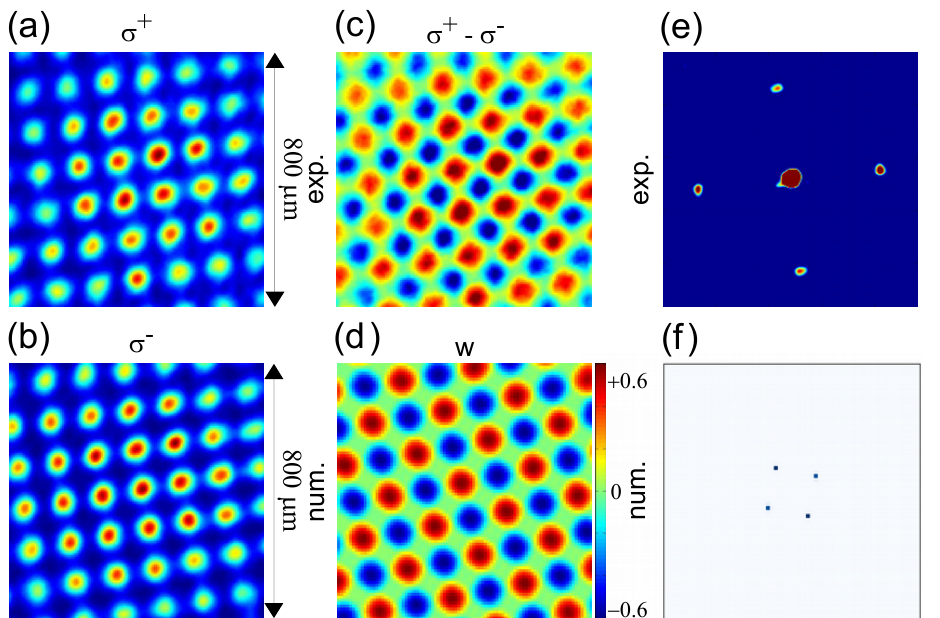
Figure 10. Spontaneous antiferromagnetic ordering for B x = B y = B z = 0. ( a , b ): NF intensity pattern of the σ + and σ − components. ( c ), NF intensity difference of the σ + and σ − components. ( d ) Spatial structure of the orientation w obtained from numerical simulation. ( e ) example for FF intensity distribution experimentally observed (not the same realization as in ( a – c )). ( f ) Numerically obtained Fourier spectrum of w . Parameter of experiment: b 0 = 80, δ = − 8 Γ , I = 10 mW/cm 2 , d = − 20 mm. (subpanels ( a – d ) adapted from